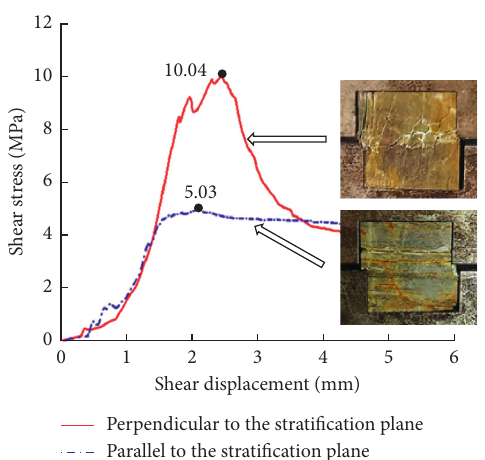
Figure 12: The curve of shear stress changing with shear